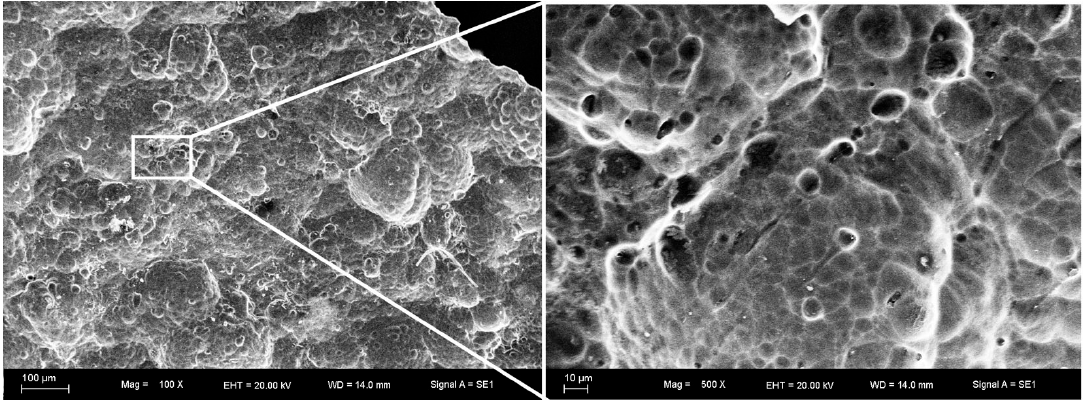
Figure 2. The surface topographies of as-received foam.